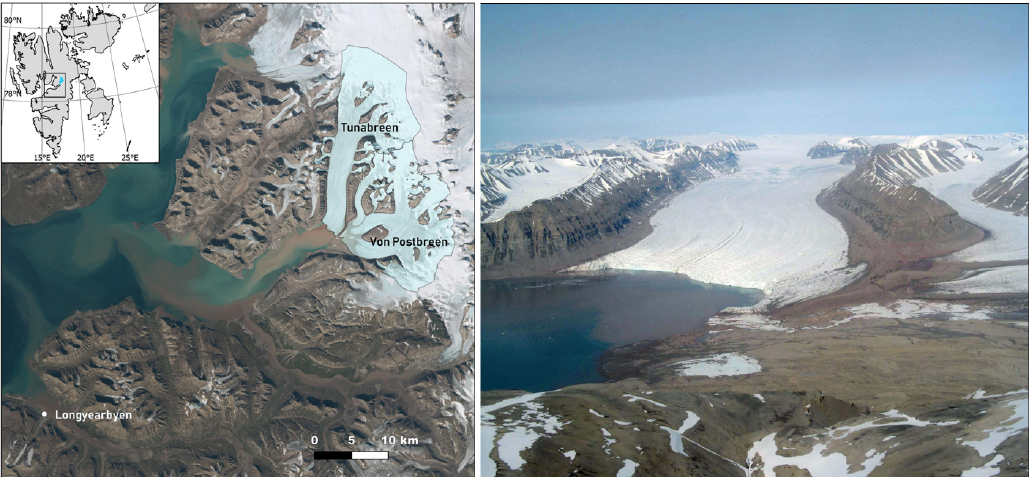
Figure 1. Left: location of Tunabreen and Von Postbreen in Svalbard (inset). Background image is from a 2020 Sentinel-2 mosaic (https:// toposvalbard.npolar.no, last access: 24 May 2022). Right: photograph of Tunabreen in 2015 (© Anders Skoglund, Norwegian Polar